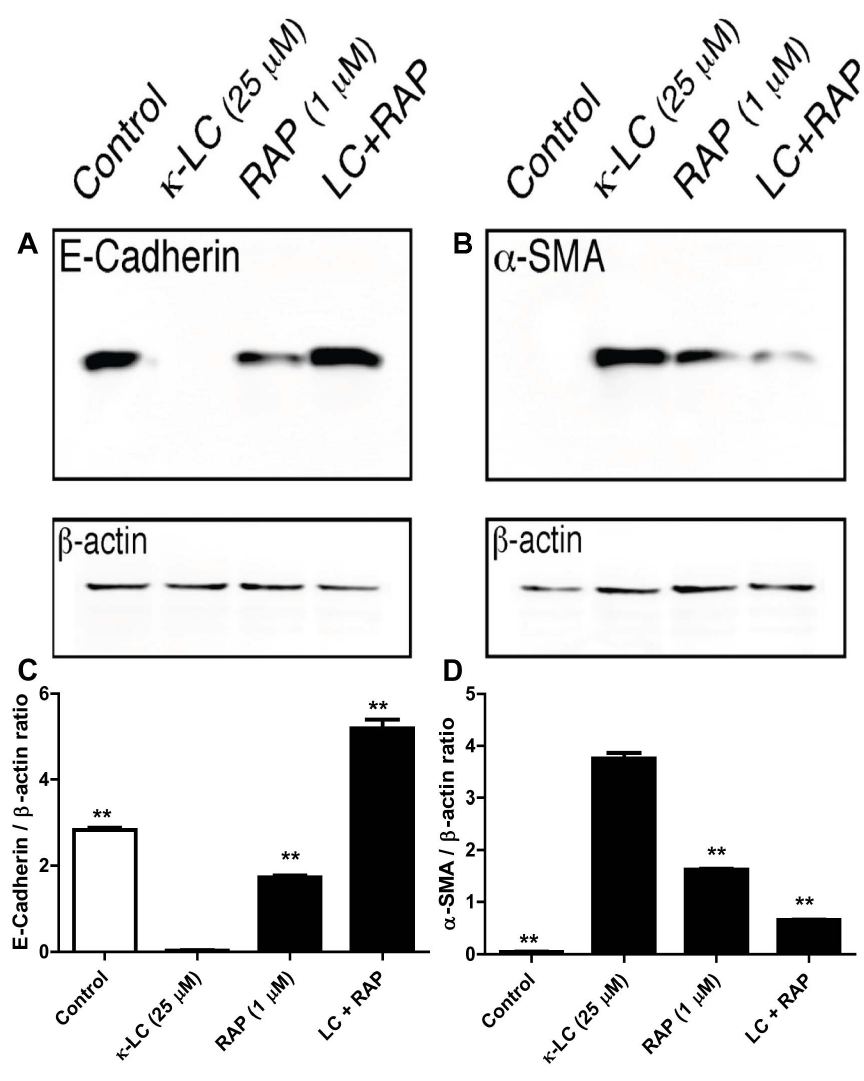
Figure 5. Effect of receptor-associated protein (RAP) on the expression of E-cadherin and a -SMA in myeloma light chain exposed human renal proximal tubule epithelial cells. RAP, 1 m M, prevented LC induced decrease in the epithelial cell marker E-cadherin ( A ), and reduced the increased expression of myofibroblast marker a -SMA ( B ), demonstrating that RAP protected cells from LC-induced EMT (representative blot from 3 experiments). Quantitative densitometric measurement of the effect of RAP pre-treatment followed by k -LC in HK2 cells on the production of E-cadherin ( C ) and a -SMA ( D ) proteins. **p , 0.01 compared to k -LC alone.